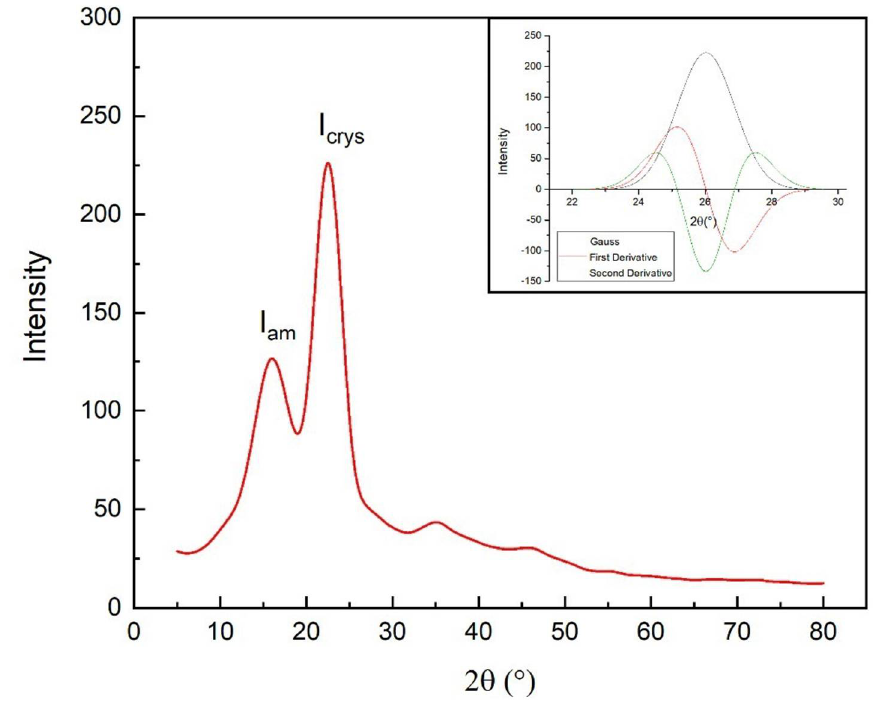
Figure 8. X-ray diffractogram of kenaf fiber. Insertion: deconvolution for calculation of the microfibrillar angle (MFA).